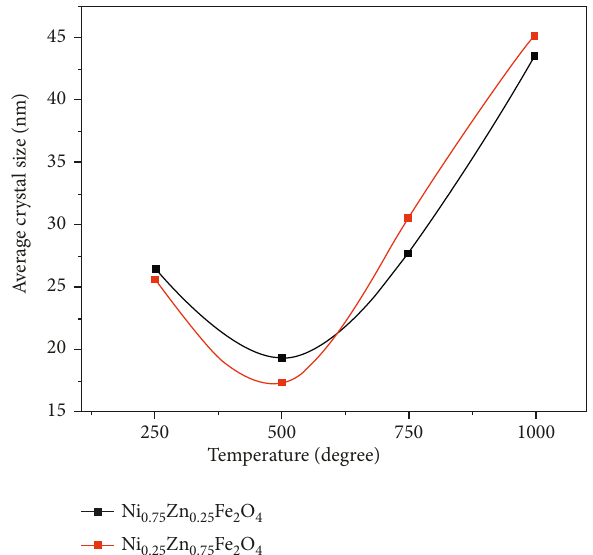
Figure 5: The average crystal size ( D Sch ) of synthesized Ni 1-x Zn x Fe 2 O 4 ferrites ( x